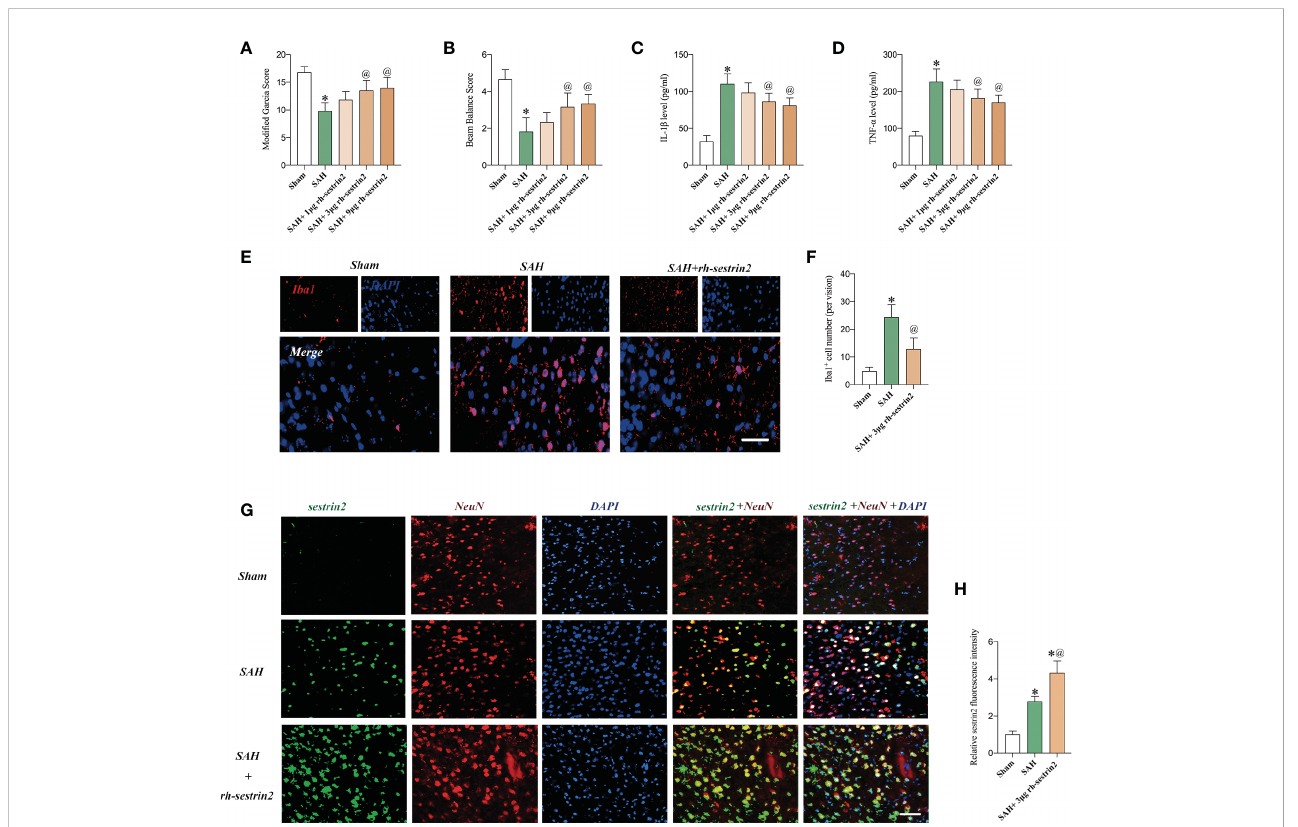
FIGURE 2 Rh-sestrin2 improved neurological function and reduced neuroin fl ammatory insults after SAH. (A) Modi fi ed Garcia score and (B) beam balance score indifferent experimental groups (n = 6 per group). Quantitative analyses of (C) IL-1 b and (D) TNF- a in different experimental groups (n = 6 per group). (E) Representative immuno fl uorescence staining for Iba1. (F) Quantitative analysis of Iba1 staining (n = 6 per group). (G) Representative images and (H) quanti fi cations of sestrin2 staining in different groups (n = 6 per group). * P < 0.05 versus sham group. @ P < 0.05 versus SAH group. Data indicated asmean ± SD. Scale bars = 50